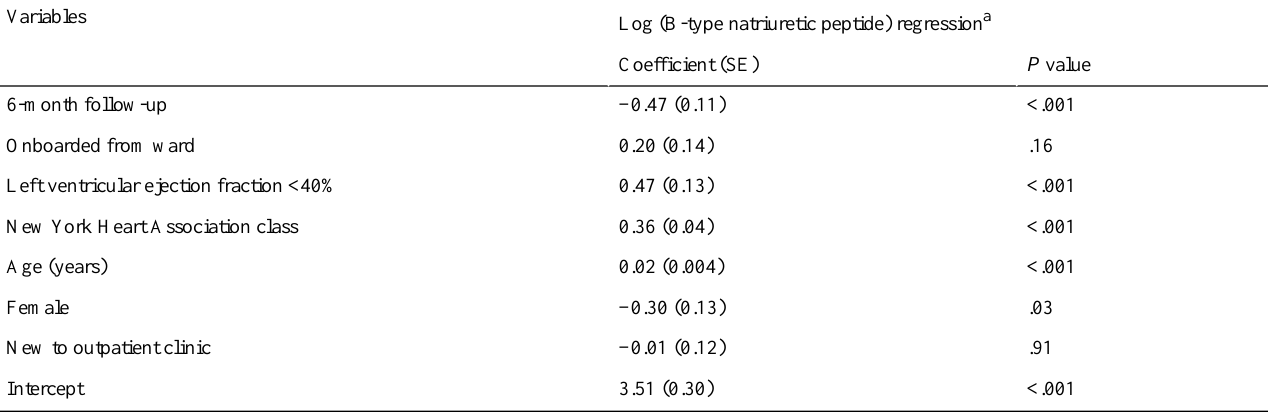
Table 3. Linear regression showing the effect of 6 months in the Medly program on B-type natriuretic peptide when controlled for key demographic and clinical